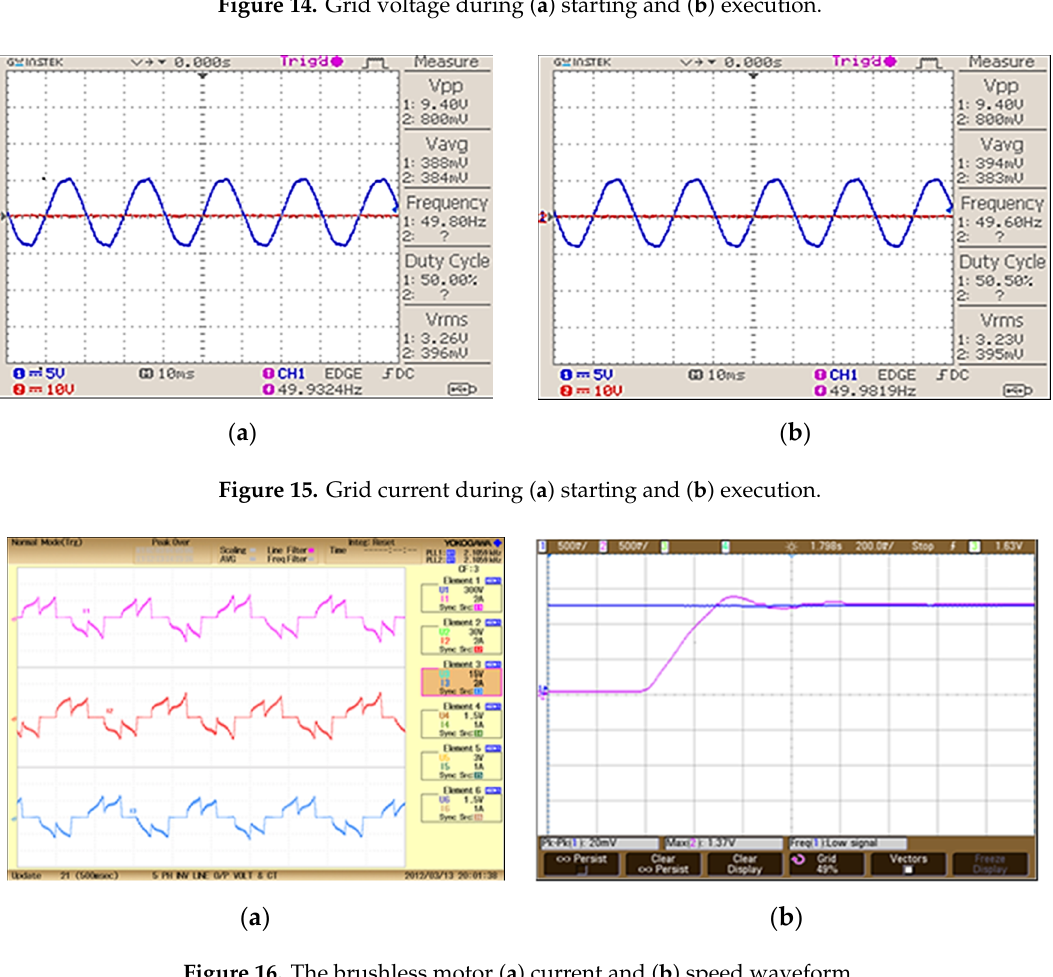
Figure 16. The brushless motor ( a ) current and ( b ) speed waveform.